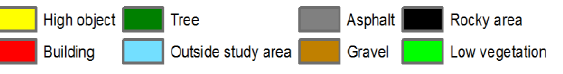
Figure 1. Legend of classified images in Figures 2 to 6. Class